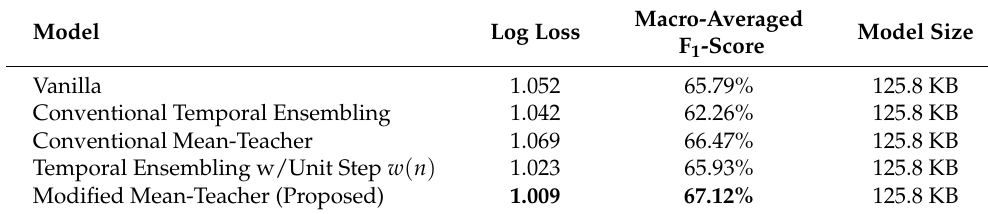
Table 2. Performance comparison between the proposed model, the conventional mean-teacher model, the temporal ensembling models, and the vanilla model without any ensemble guidance. Macro-Averaged Model Log Loss Model Size F 1 -Score Vanilla 1.052 65.79% 125.8 KB 1.042